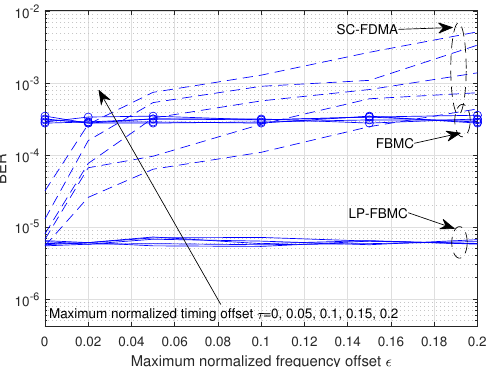
Figure 14. BER of the SC-FDMA, FBMC, and LP-FBMC according to timing/frequency offset, N = 128, ∆ f = 15 kHz, F = 3.5